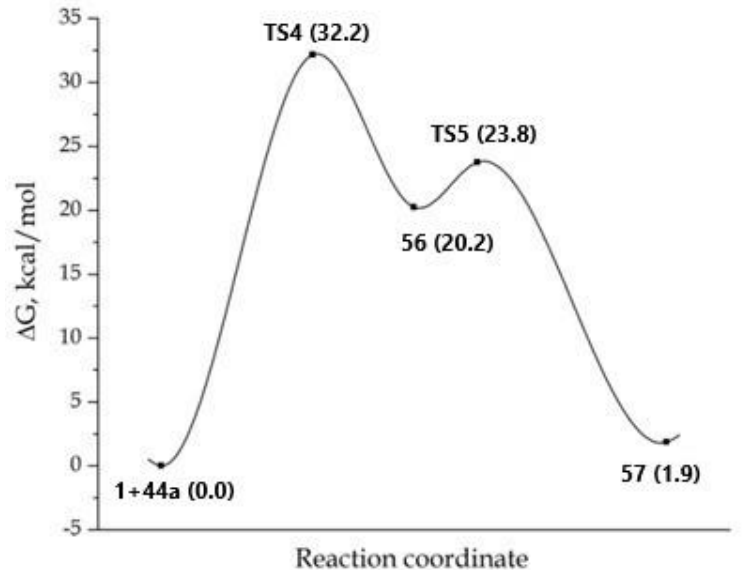
Figure 4. MEP for the reaction concerning the formation of adduct 57 . The total energy of the starting reagents 1 and 44а was taken as the reference point.